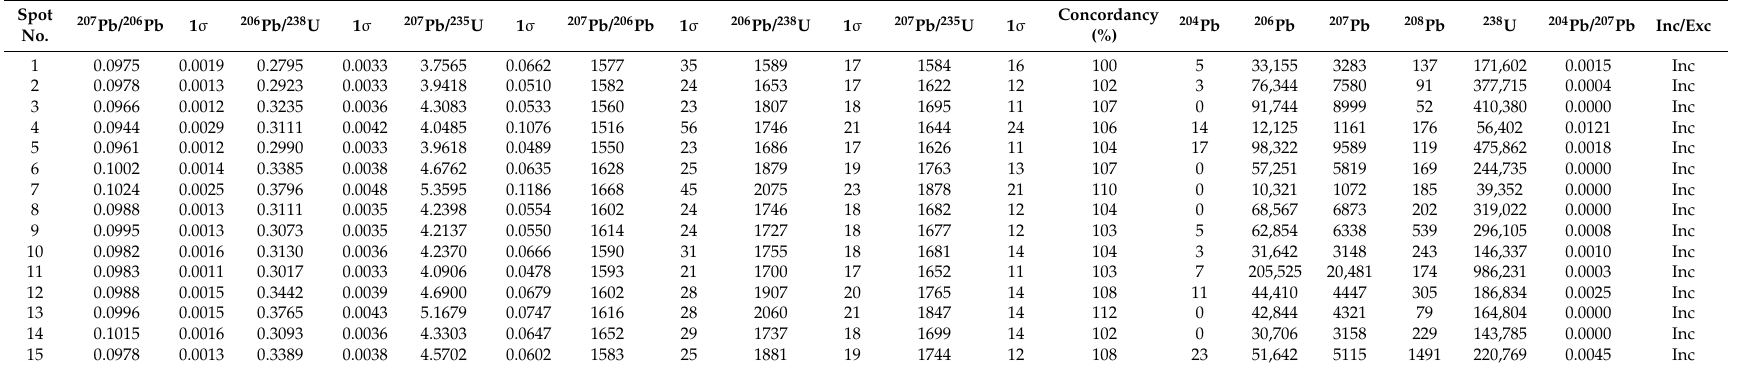
Table 2. Geochronological data for zoned hematite (sample OD10-4) using mixed-solution method.